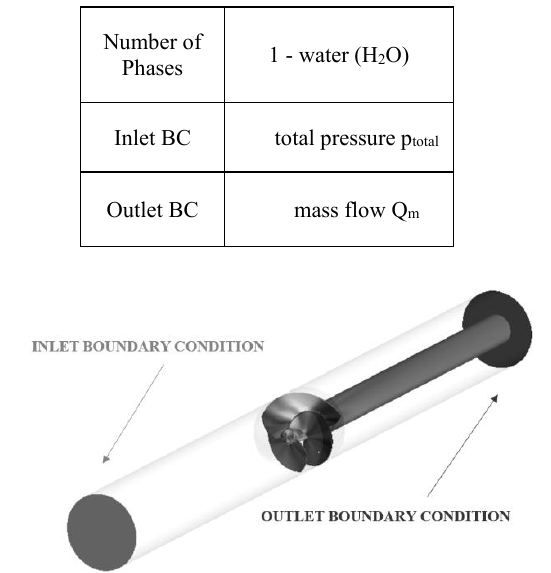
Fig. 7. Computational domain of inducer alone CFD calculation [3]